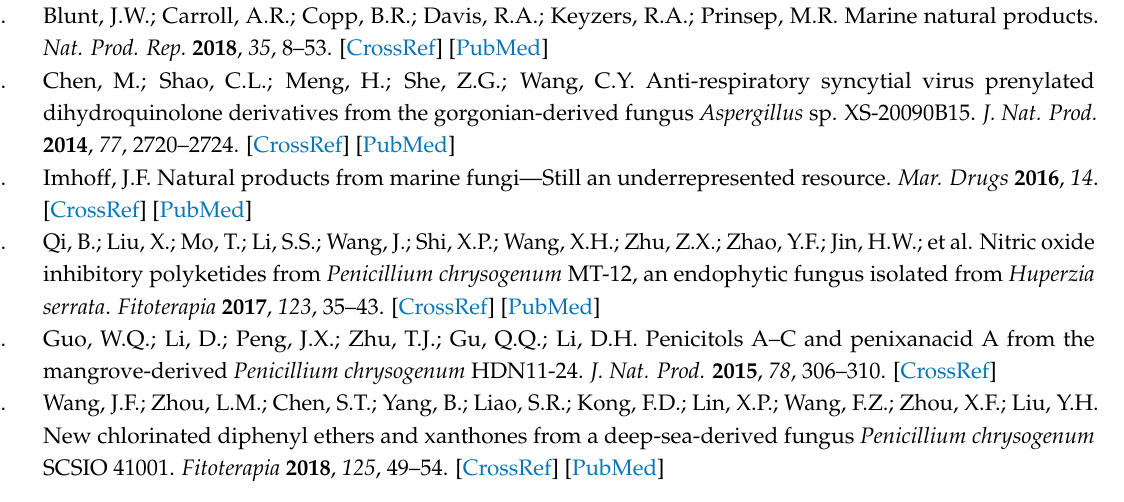
Figure S2: 1 H-NMR spectrum of 1; Figure S3: 13 C-NMR spectrum of 1; Figure S4: COSY spectrum of 1; Figure S5: HSQC spectrum of 1; Figure S6: HMBC spectrum of 1; Figure S7: NOESY spectrum of 1; Figure S8: HRESIMS spectrum of 2; Figure S9: 1 H-NMR spectrum of 2; Figure S10: 13 C-NMR and DEPT spectra of 2; Figure S11: COSY spectrum of 2; Figure S12: HSQC spectrum of 2; Figure S13: HMBC spectrum of 2; Figure S14: NOESY spectrum of 2; Figure S15: Structure and population of the low-energy B3LYP/6-31G(d) conformers (>2%) of (20 S ,25 S )-1; Figure S16: Structure and population of the low-energy B3LYP/6-31G(d) conformers (>2%) of (20 S ,25 S )-2; Table S1: Cartesian coordinates of the low-energy conformers ( ≥ 2%) of 1; Table S2: Cartesian coordinates of the low-energy conformers ( ≥ 2%) of